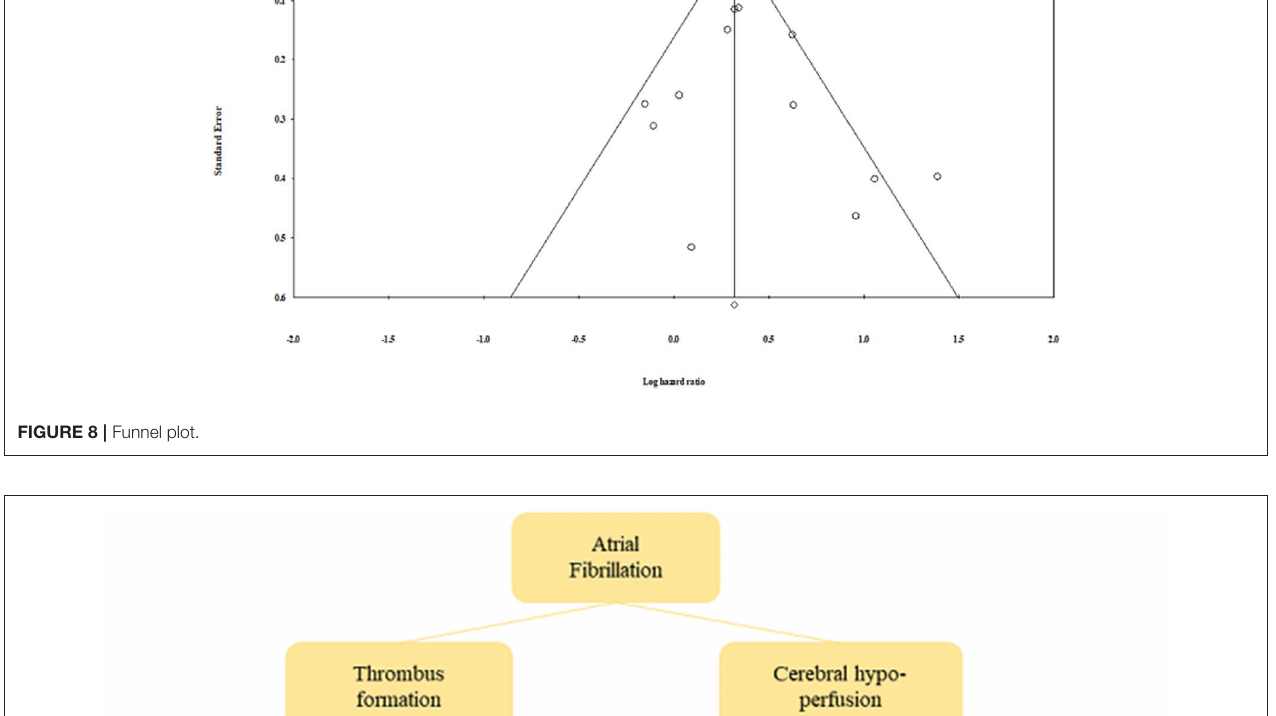
2,685 dementia-free individuals from the Swedish National Study on Aging and Care in Kungsholmen, Stockholm. AF patients with OACs had a decreased risk of dementia (HR = 0.44, 95% CI: 0.18–0.92) compared to those patients without OACs (Ding et al., 2018). However, long-term anticoagulation therapy might